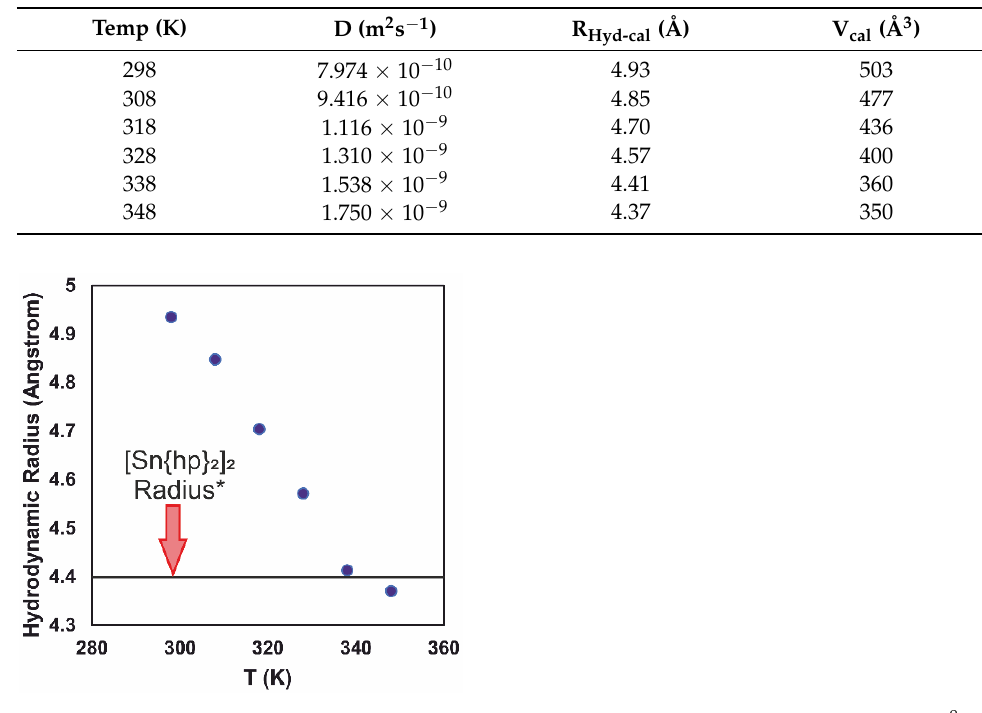
Table 1. Experimentally determined ( 1 H DOSY NMR) diffusion coefficients (D), calculated Hy- drodynamic radii (R Hyd-cal ) and calculated Molecular volume (V cal ) of 2 at temperatures between 298–348 K.